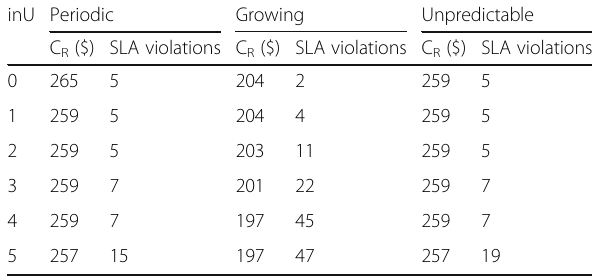
Table 11 Impact of increasing inU on the cost factors inU Periodic Growing Unpredictable